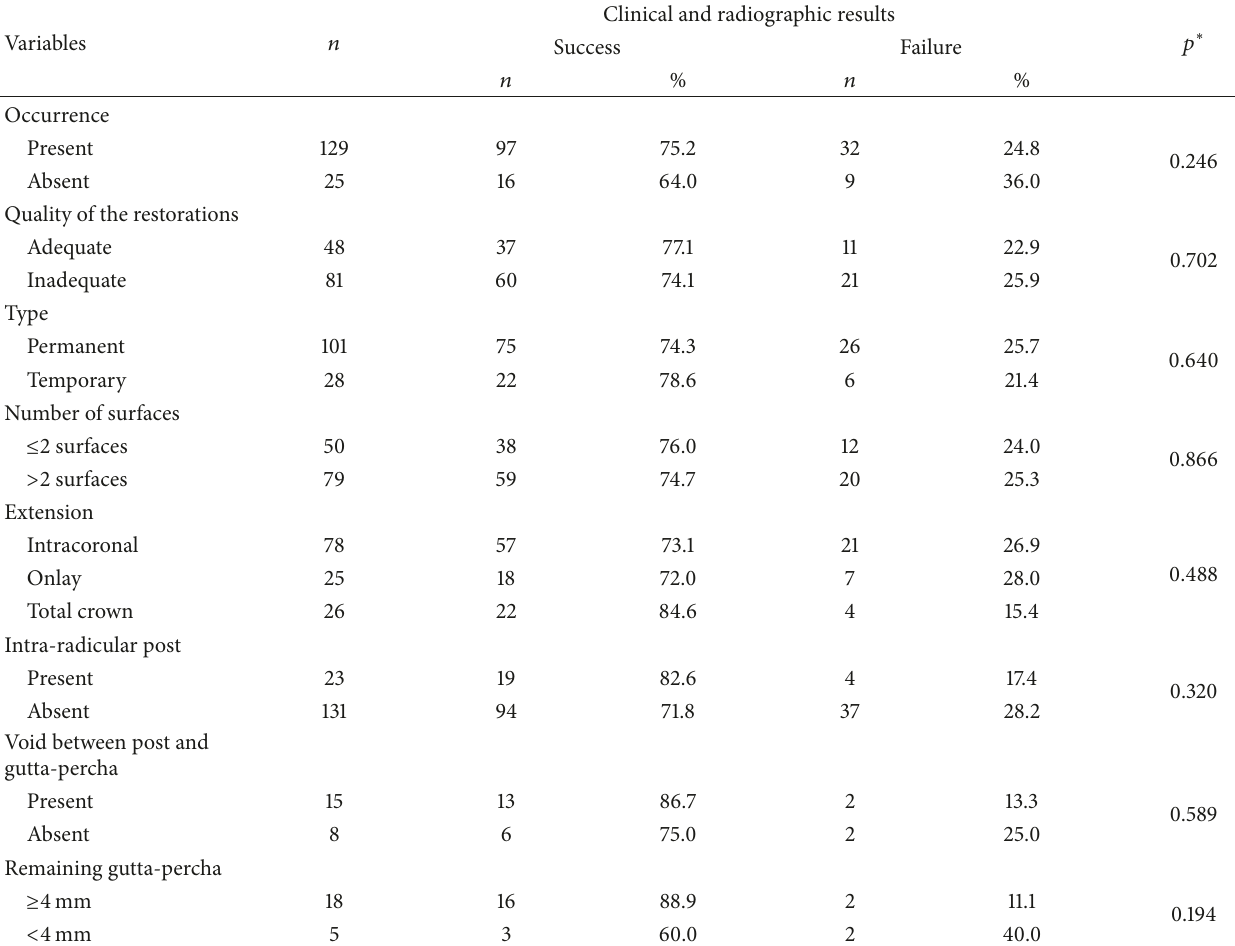
Table 3: Clinical and radiographic success according to coronal restoration parameters.